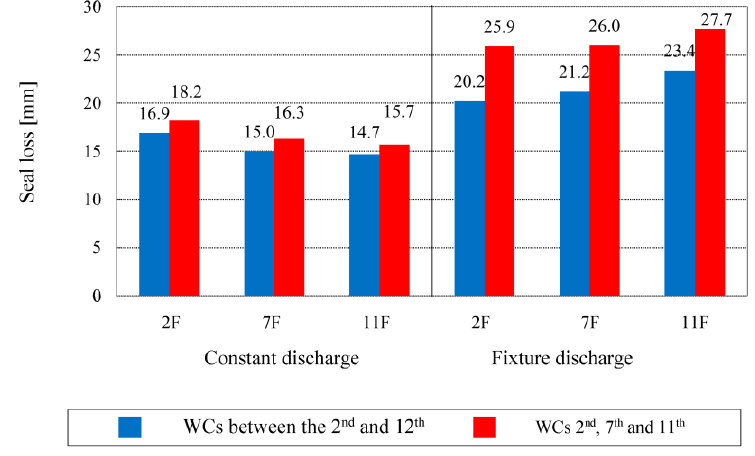
Figure 9. Relationship of seal loss on each floor in each type of discharge.